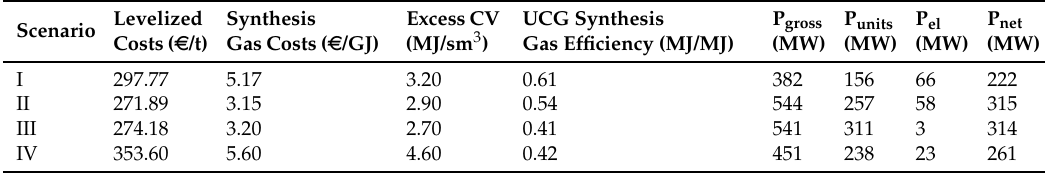
Table 21. One-at-a-time sensitivity analysis results for the onshore UCG-NH 3 -CCS scenario considering different synthesis gas compositions and calorific